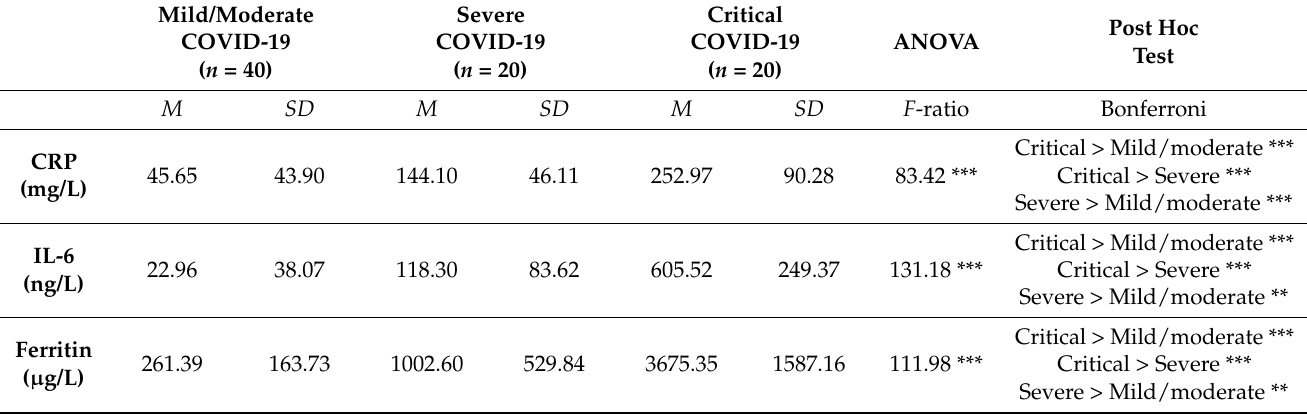
Table 3. Correlation of proinflammatory biomarkers CRP, IL-6 and ferritin with the severity of disease.